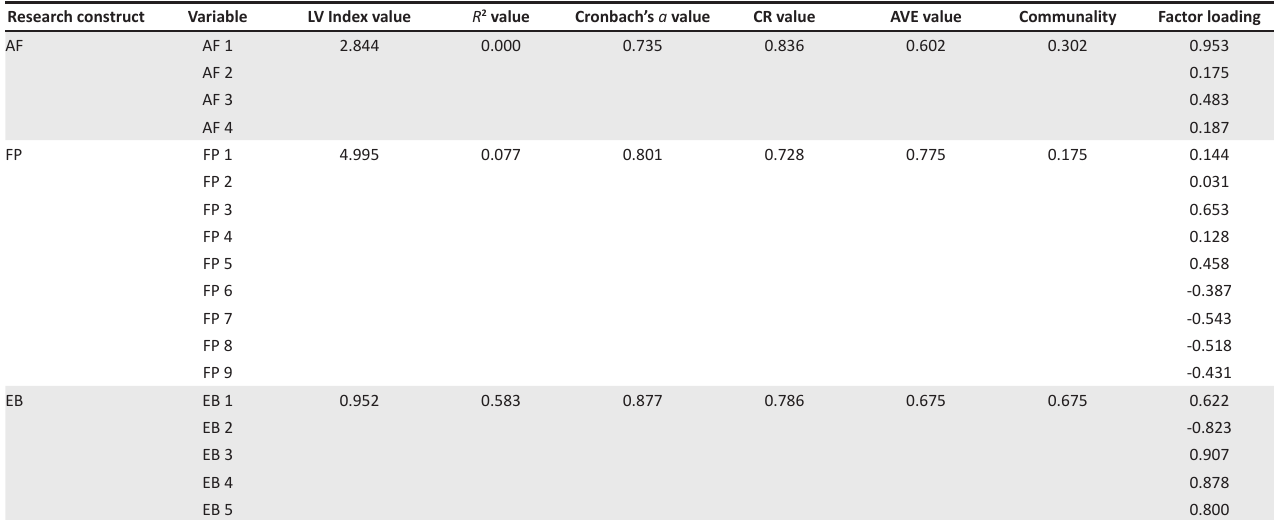
TABLE 2: Accuracy analysis statistics.